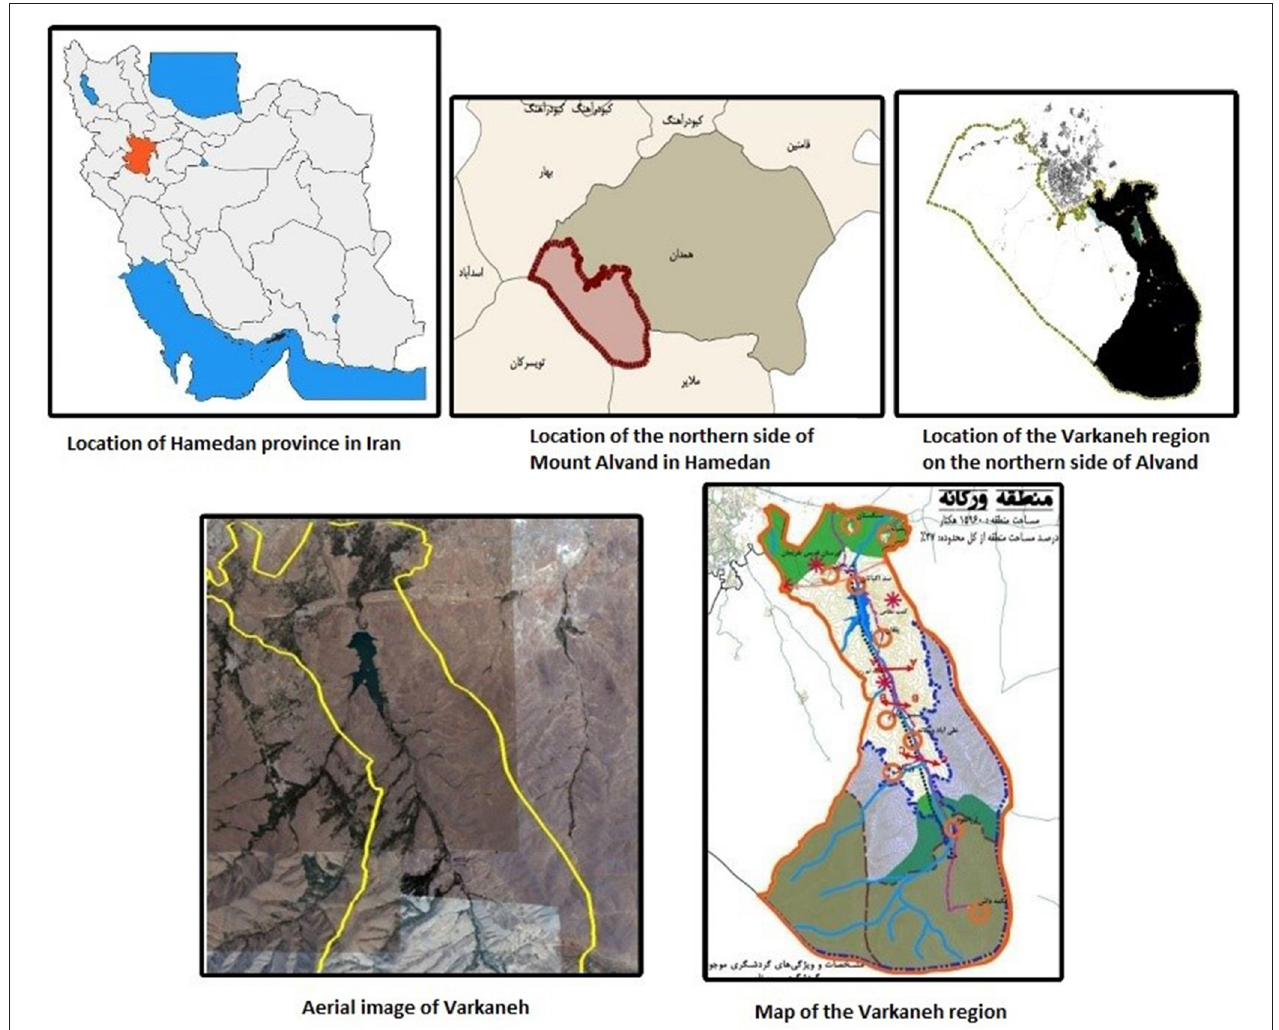
FIGURE 1 | The geographical location of the Varkaneh region. The study for researching and organizing the north side of the Alvand Mountains.